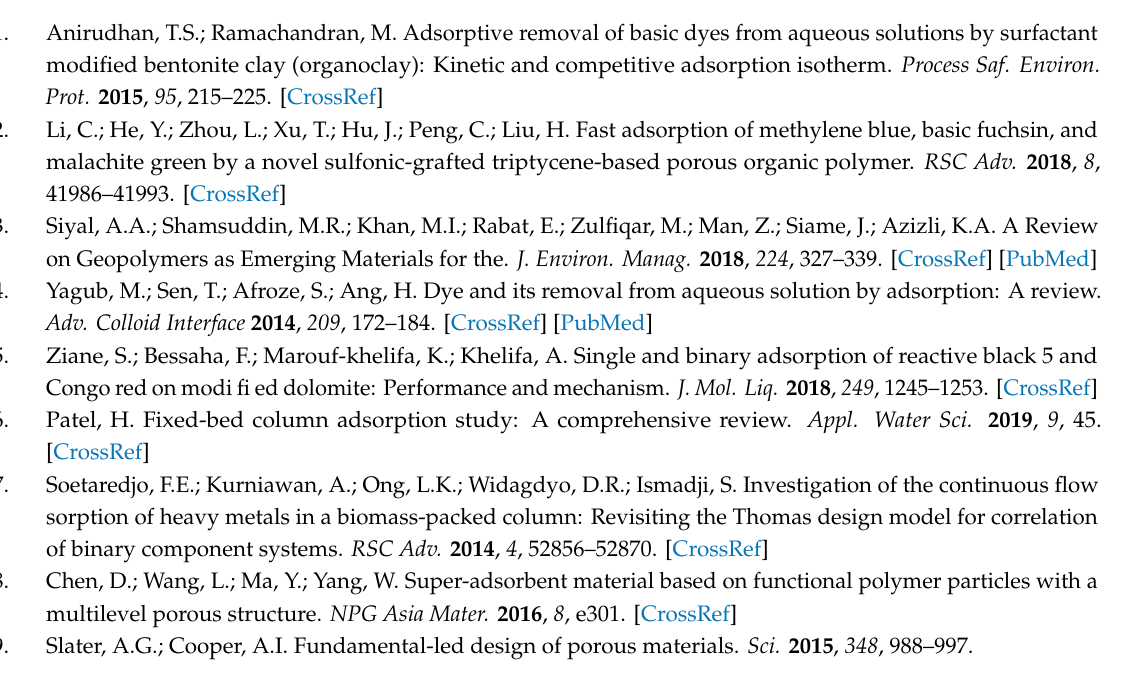
Figures: Linear Regression Analysis for breakthrough curve modeling by Thomas model (Figure S1), Bohart-Adams model (Figure S2) and Yoon-Nelson model (Figure S3) for adsorption of MG and MB onto T-PAA in a binary solutions at di ff erent column conditions; (a) pH, (b) Concentration (mg / L), (c) Bed height, and (d) Flow rate mL /